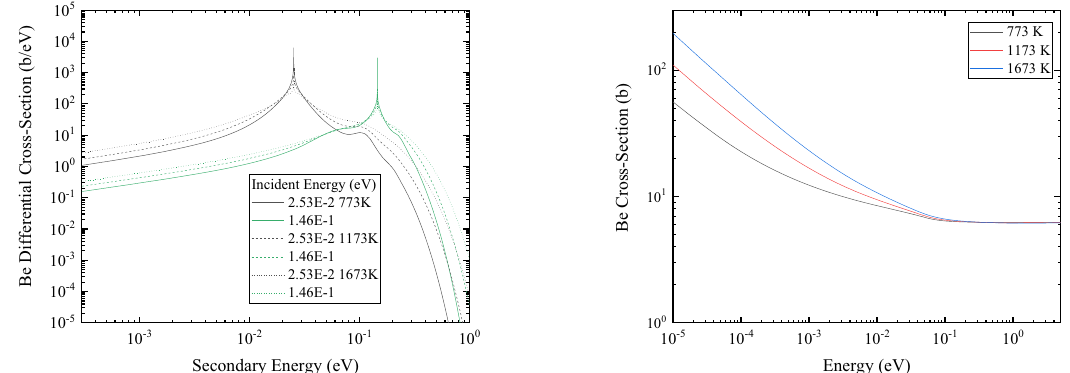
Figure 4. Secondary distribution (left, for various incident energies) and total scattering cross- section (right) for Be in FLiBe at 773 K, 1173 K, and 1673 K.